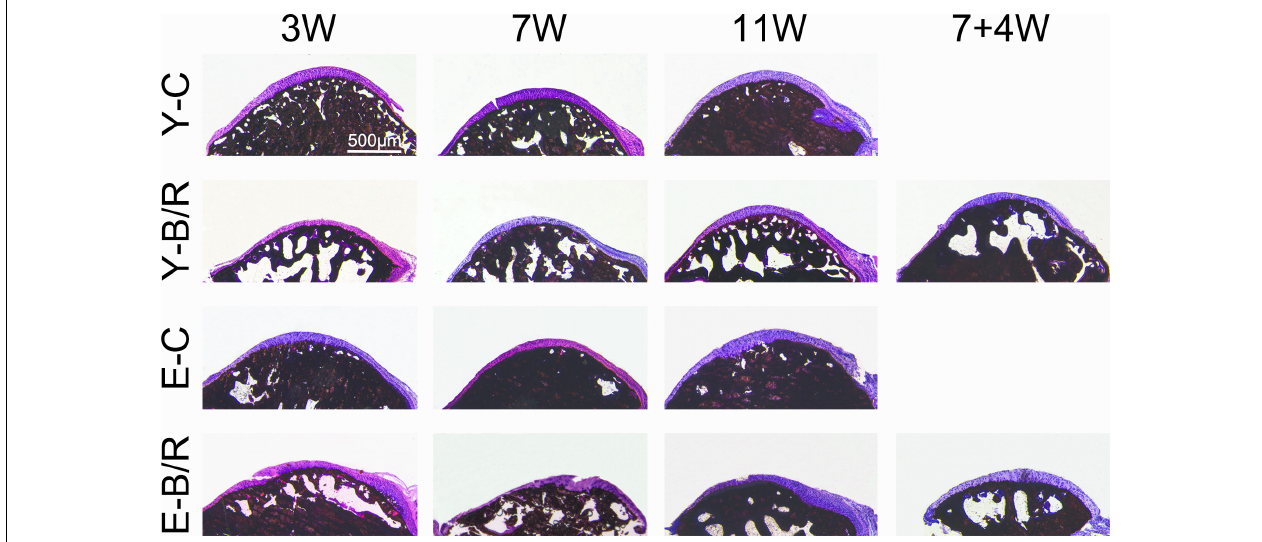
FIGURE 4 | Representative von Kossa (VK) staining. Bars = 500 µ m. For grouping and time points, please refer to Figure 1A .